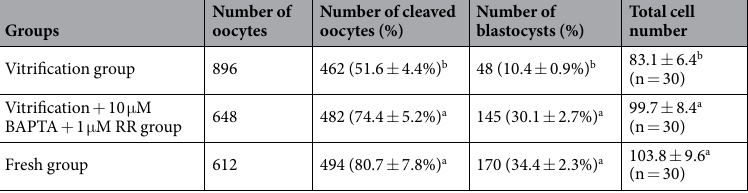
Table 6. Effect of BAPTA + RR treatment on the development of vitrified bovine oocytes after IVF. a,b Values with different superscripts differ significantly within the same column ( P <